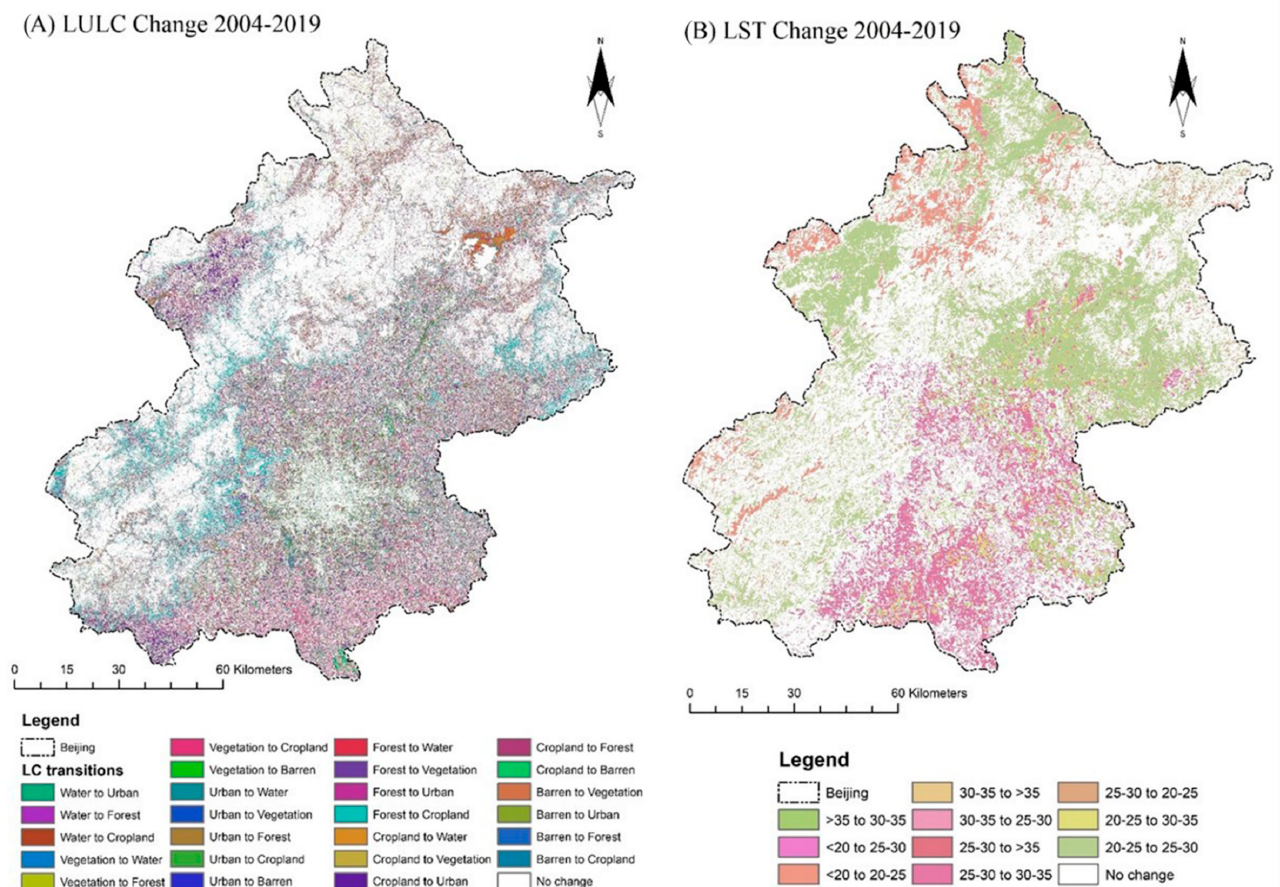
2 ) and ( B ) LST ( ◦ C) during 2004–2019.